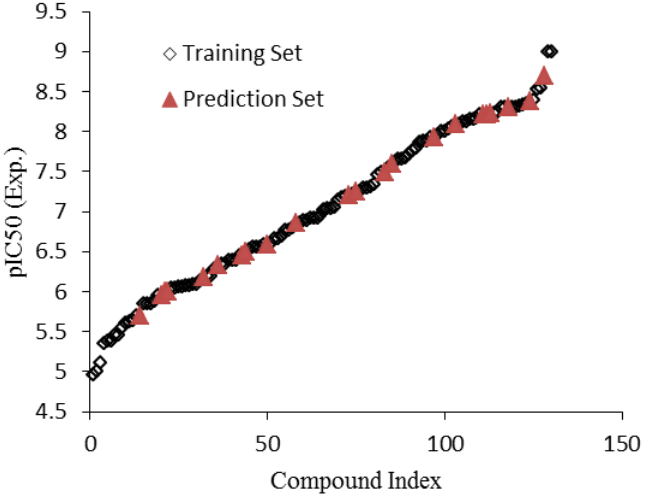
values for the whole data set. 50